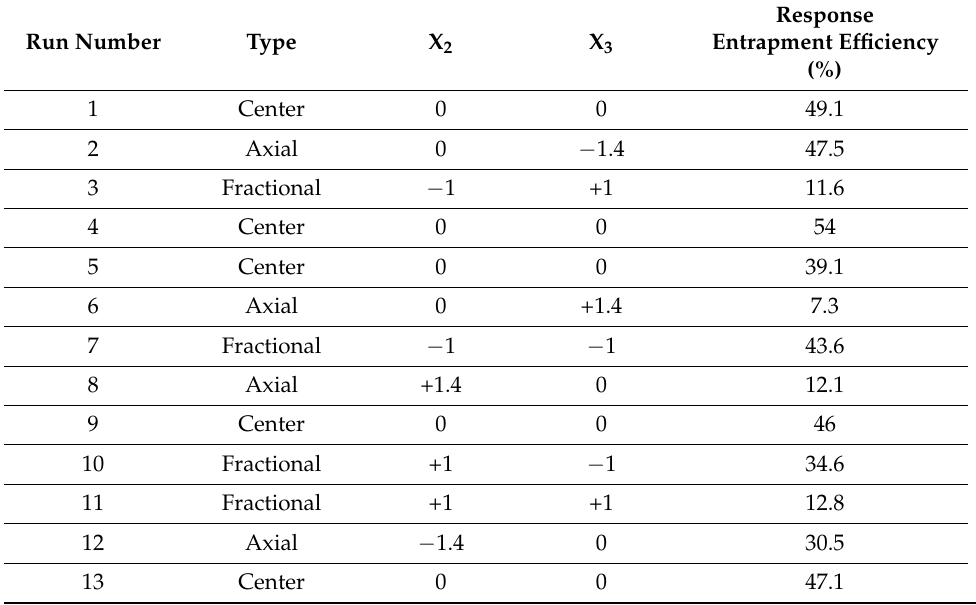
Table 6. Optimisation design of EGCG-niosome showing variables in coded values and responses.